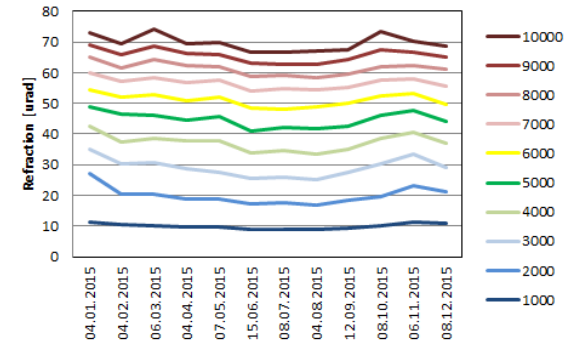
Figure 5. Seasonal change of the atmospheric refraction in Tucson AZ at different camera height over ground (1000 m – 10000 m) using the refractive index from Eqn (11) without water vapor contribution.